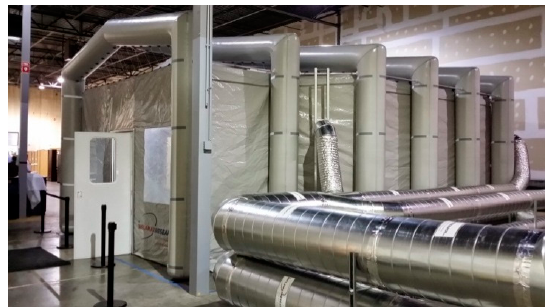
Figure 5. Mobile environmental exposure chamber (mEEC) used for the controlled clinical study.